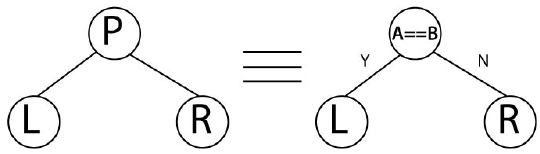
Figure 4. The decision tree P for evaluating comparators.